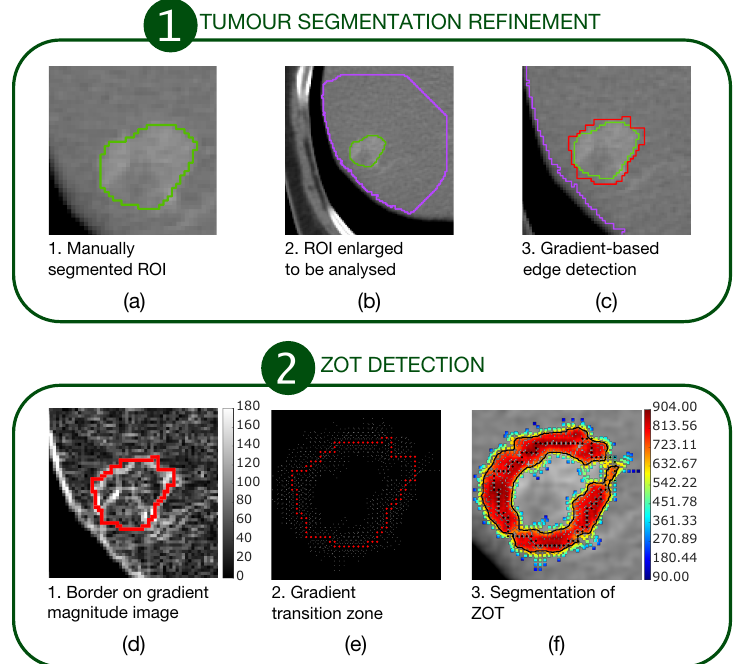
Figure 1. A two-stage procedure for ZOT detection. The first stage ( a – c ) refines the manually segmented ROIs. The second stage ( d – f ) detects ZOT, which is reconstructed starting from the tumour border, by exploring gradient variations for each pixel of the tumour